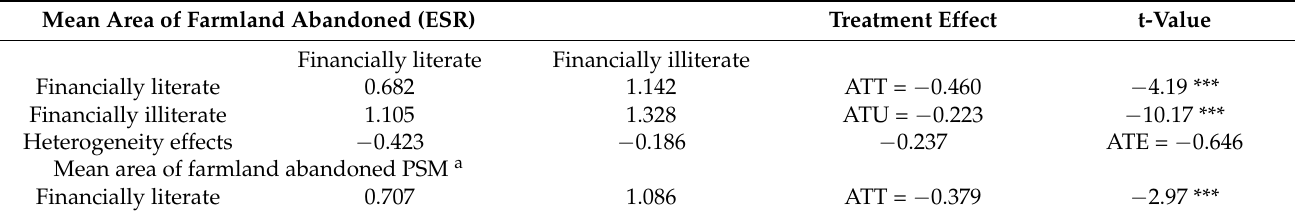
Table 4. The impact of financial literacy on the abandonment of